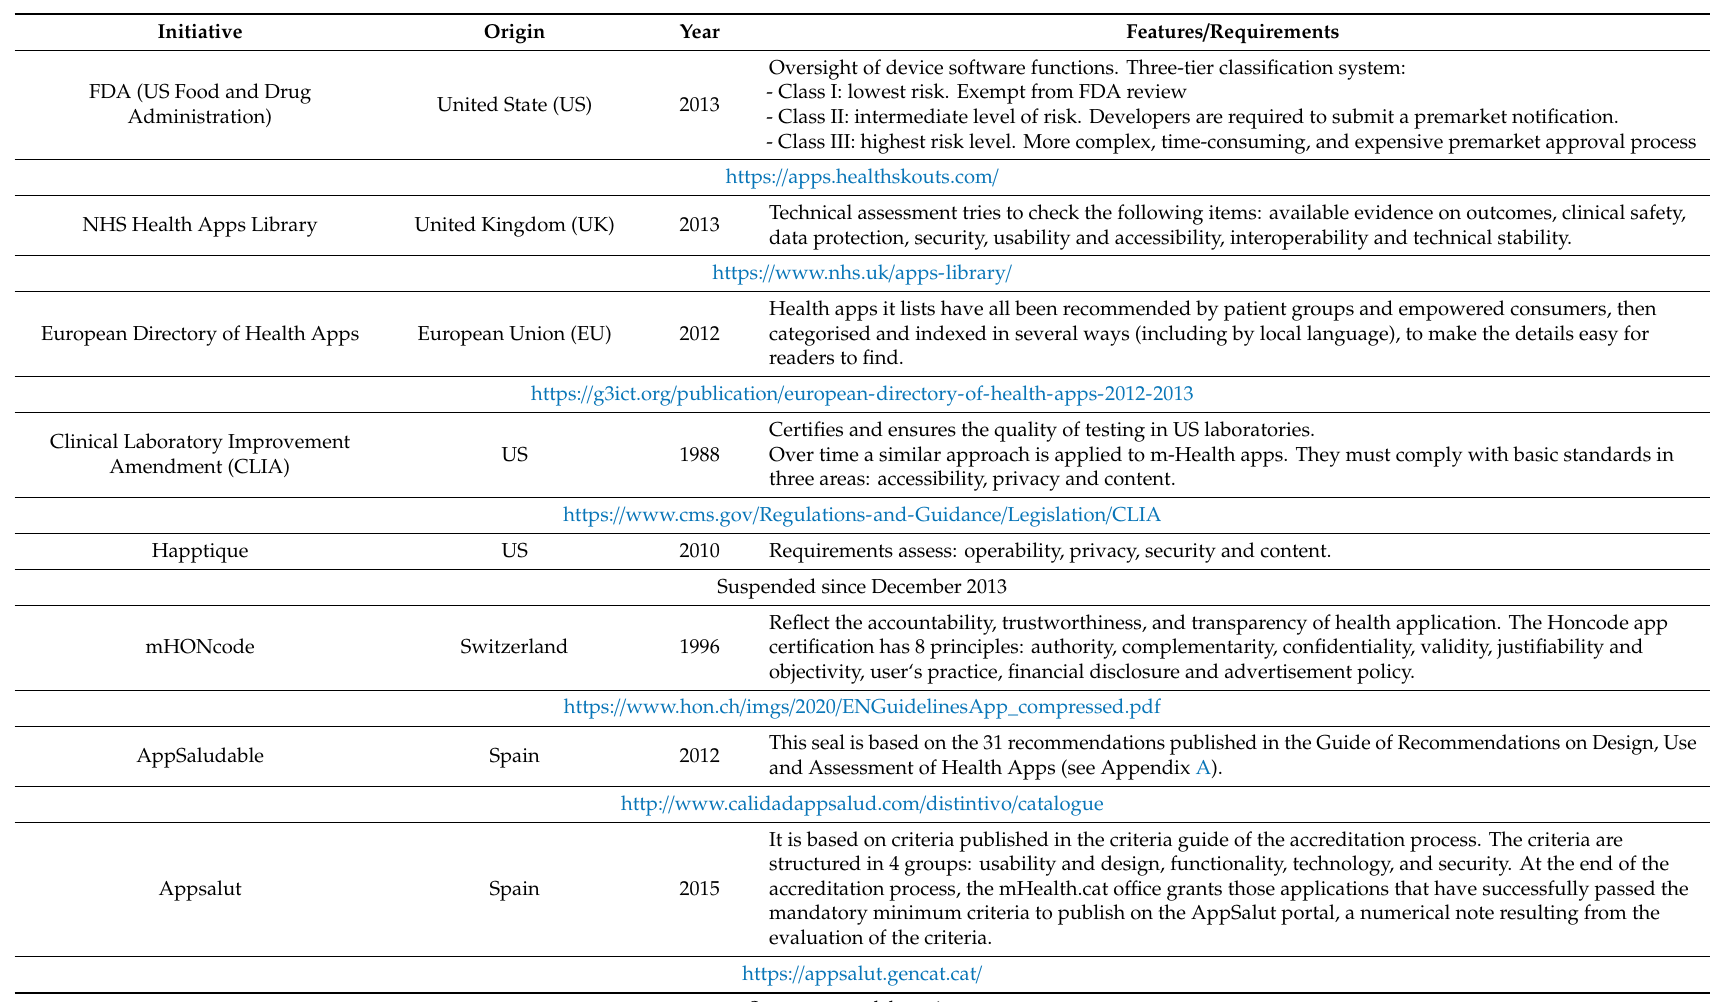
Table 1. Initiatives of accreditation de mHealth